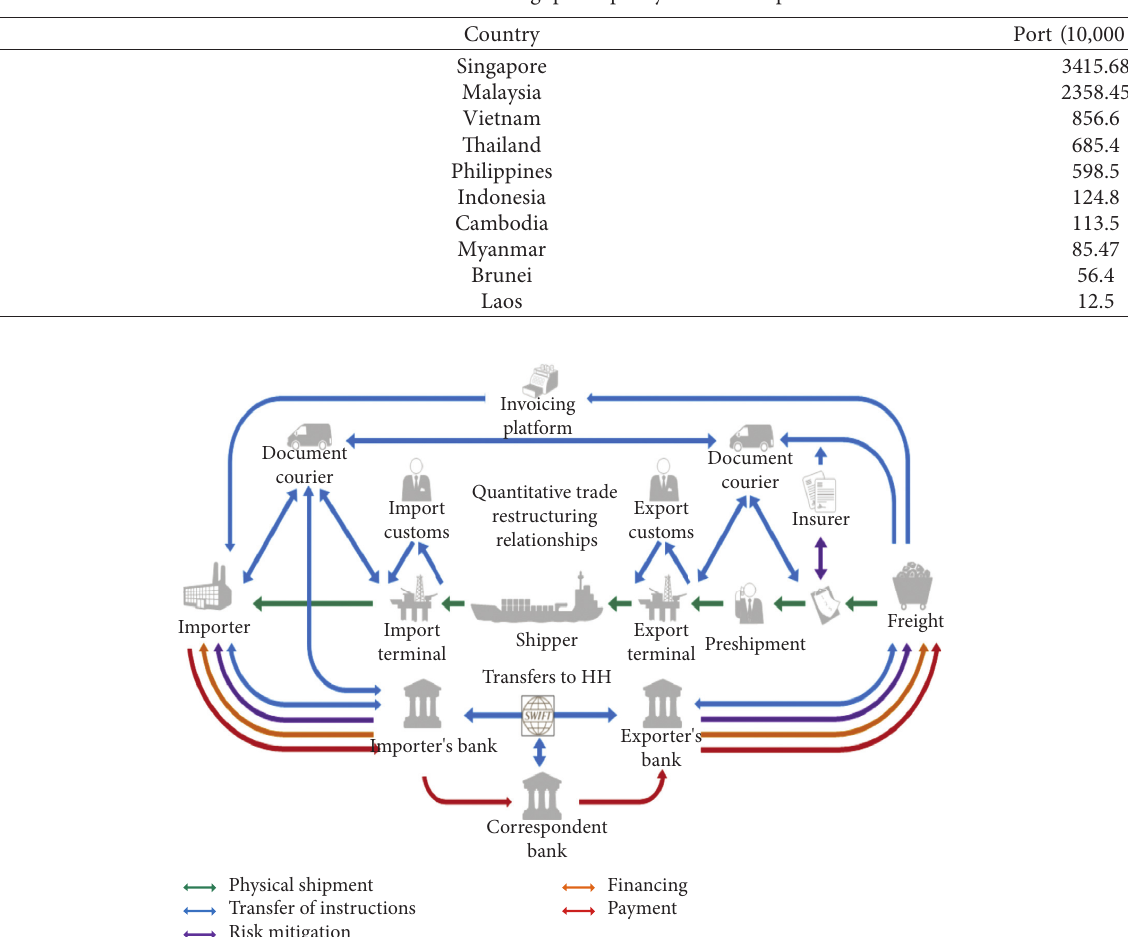
Table 1: Container throughput capacity of ASEAN